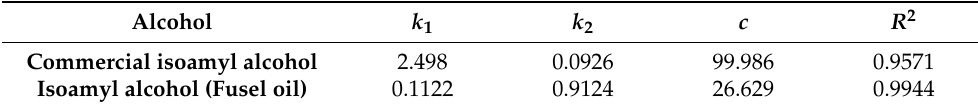
Table 2. Parameter values for Equation (5) and correlation ( R 2 ) upon fitting of relative yields with commercial isoamyl alcohol and isoamyl alcohol contained in fusel oil.